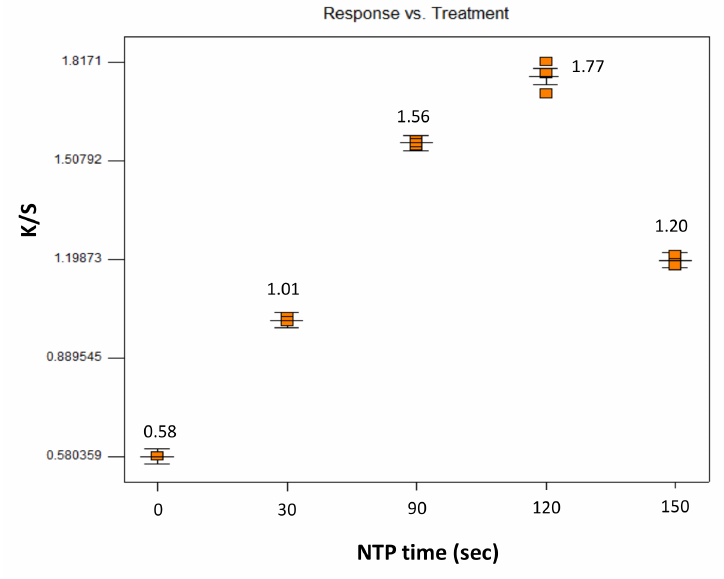
Figure 6. Effect of NTP time on K/S value of soybean oil-soaked